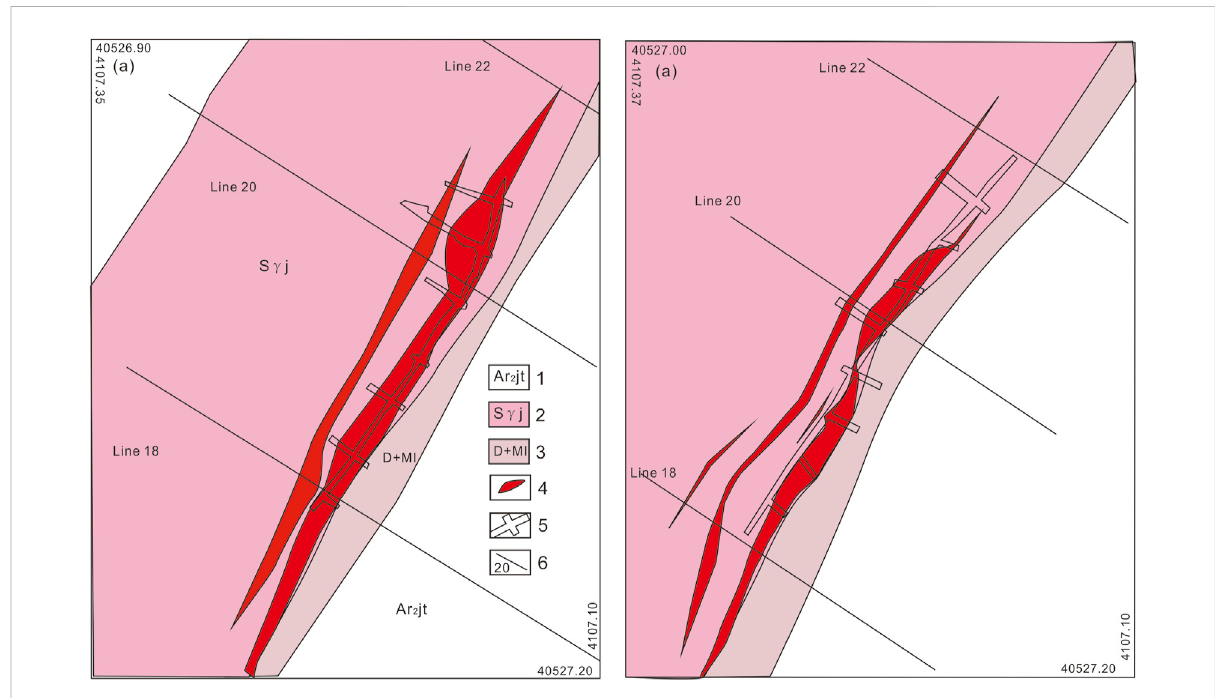
FIGURE 8 Geological map of tunnel samplings. (A) At the depth of − 50 m; (A) At the depth of − 100 m; 1- Archean plagioclase gneiss; 2- Sericitization granite; 3- Fault gouge and mylonite; 4- gold ore bodies; 5- tunnel; 6- geological pro fi